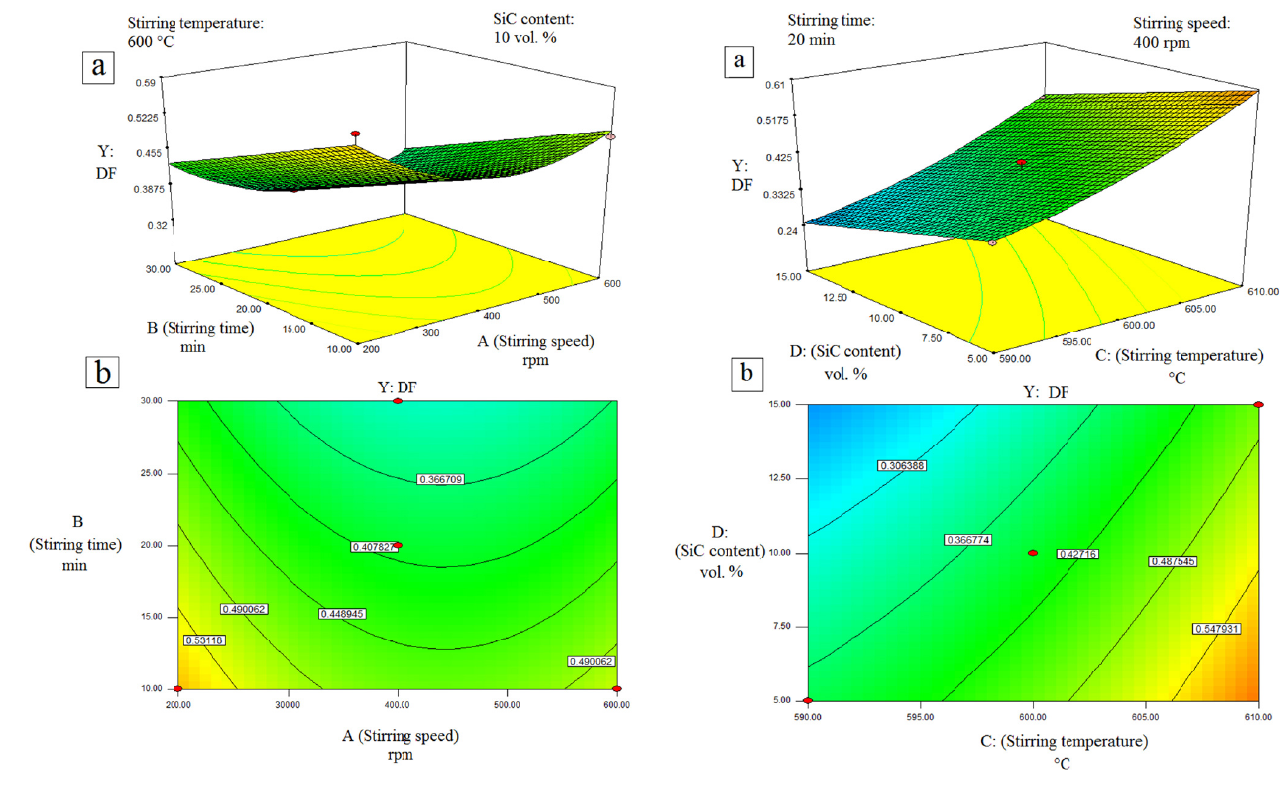
Fig. 4. a) Response surface and b) contour plots for the effect of the stirring temperature and SiC content on the DF .